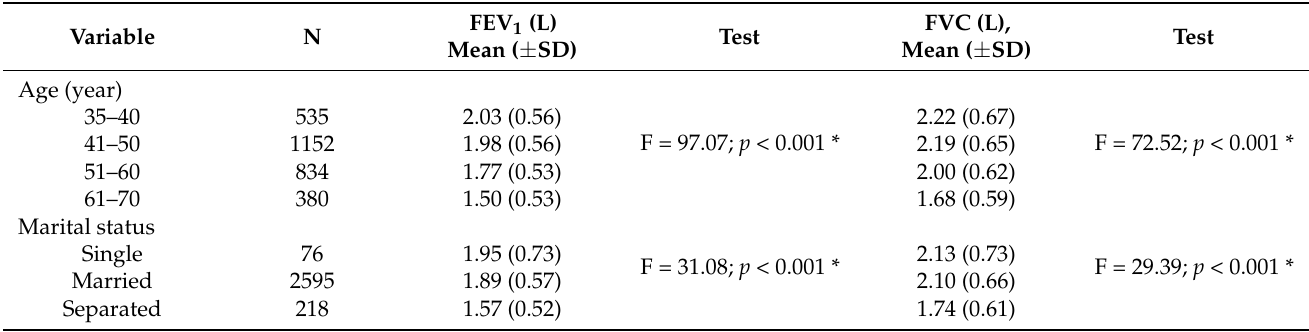
Table 3. Comparisons of lung function indices by respondents’